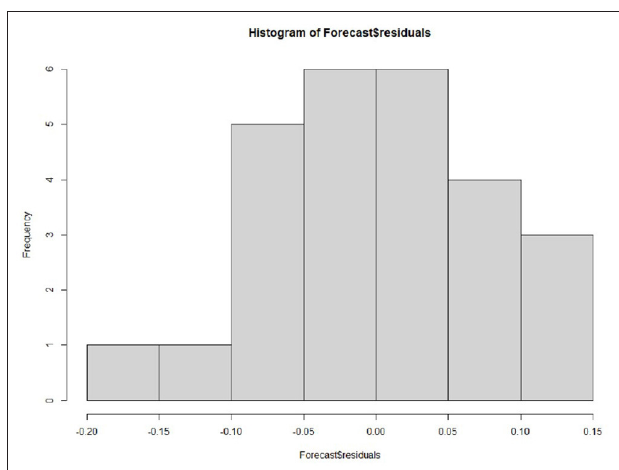
FIGURE 8 | Histogram of prediction